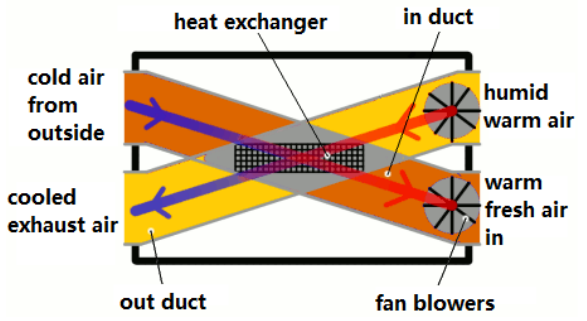
Figure A6. Schematic of HRV functionality.